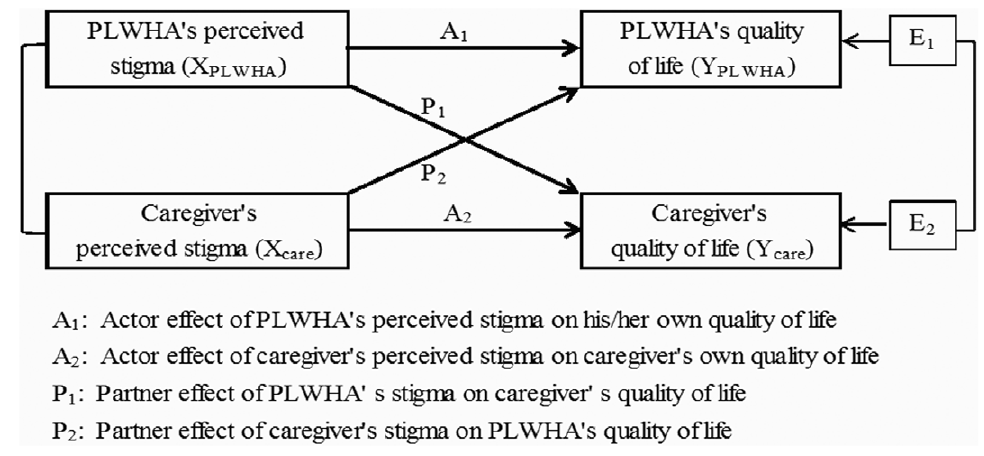
Figure 1. Actor Partner Interdependence Model Examining Actor and Partner Effects on Quality of Life.